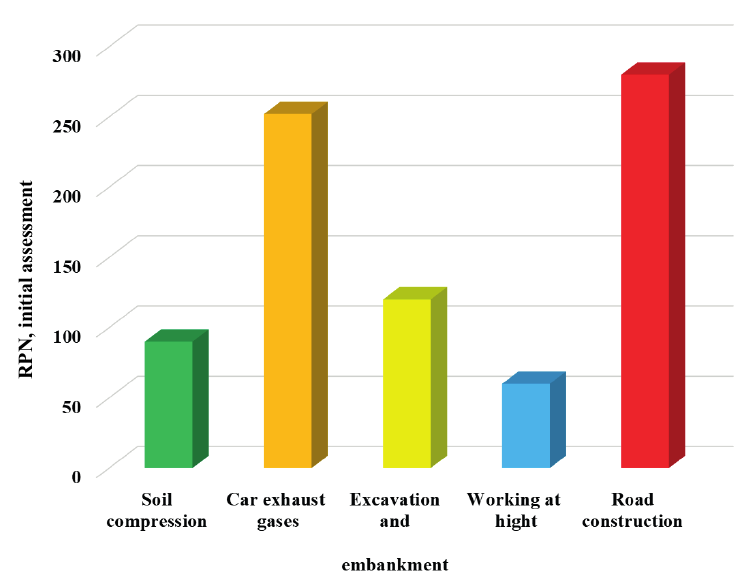
Fig. 3. Risk level assessment in the construction